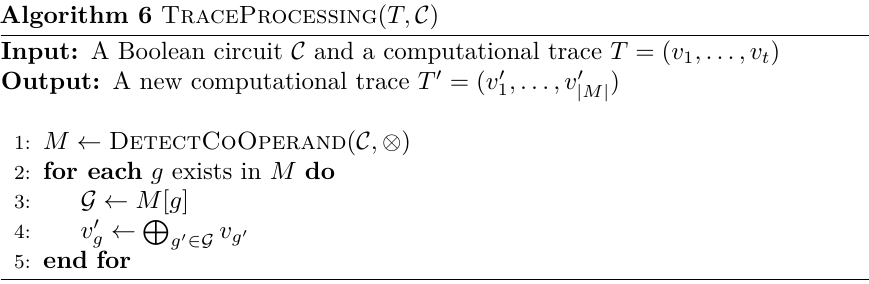
Algorithm 6 TraceProcessing ( T, C )